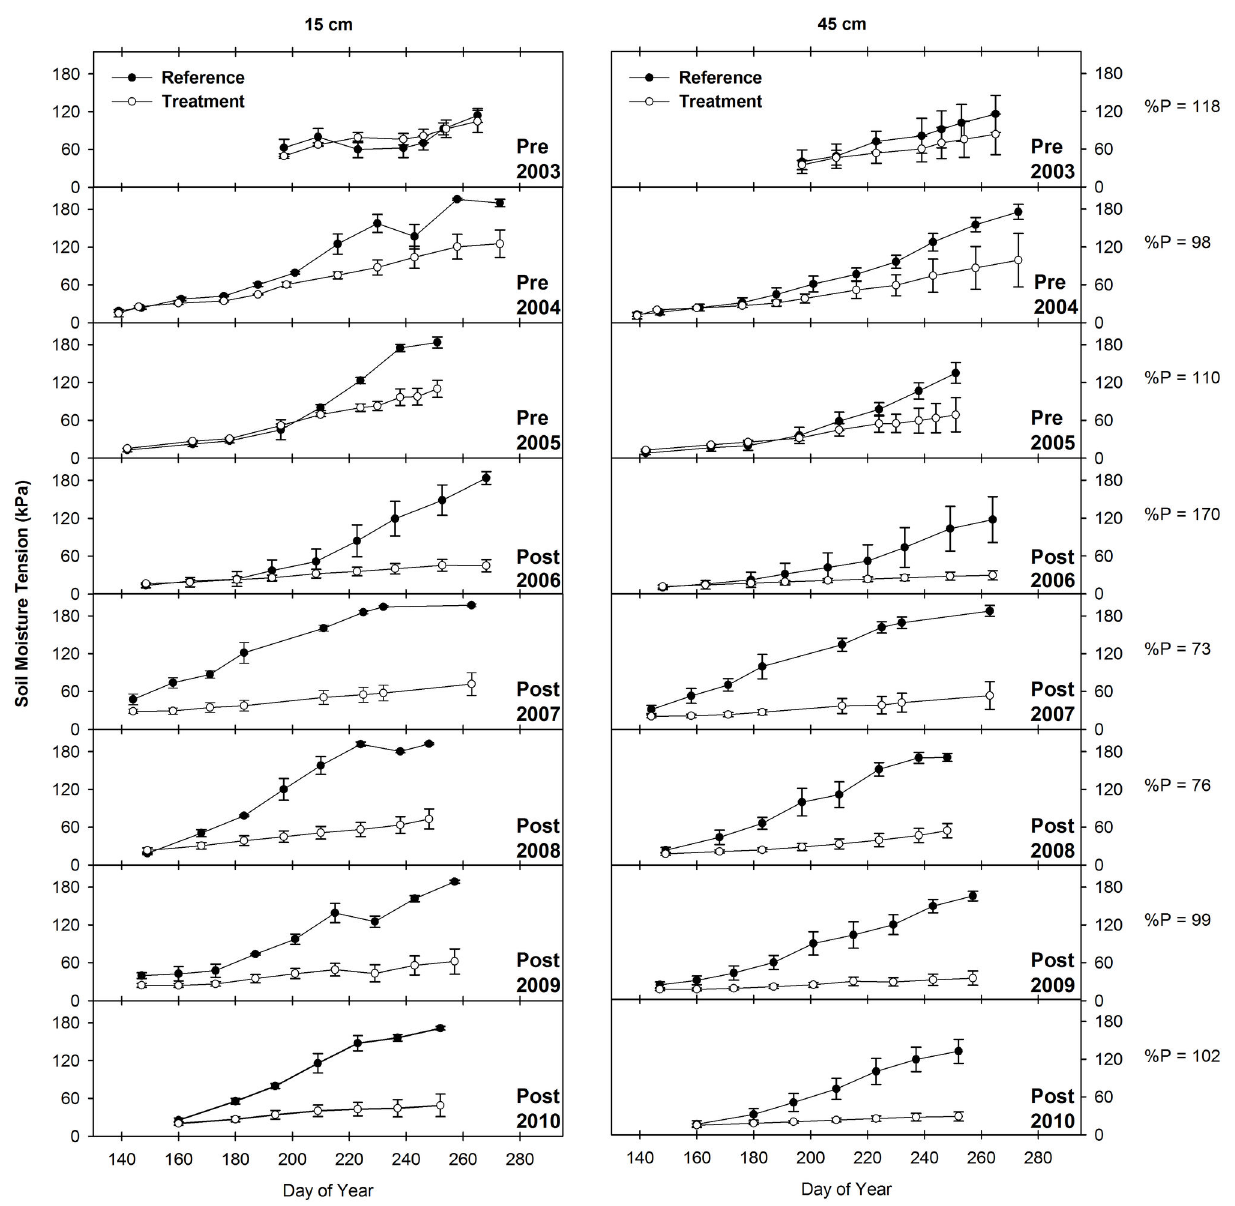
Figure 8. Mean and standard error of soil moisture within the Pine-Bogard Phase 2 August 2005 treatment area. Measurements were made at the 15 and 45 cm depths at Stations C and D of the reference and treatment transects. % P = percent of mean annual precipitation. Lower values of soil moisture tension correspond to wetter soils.